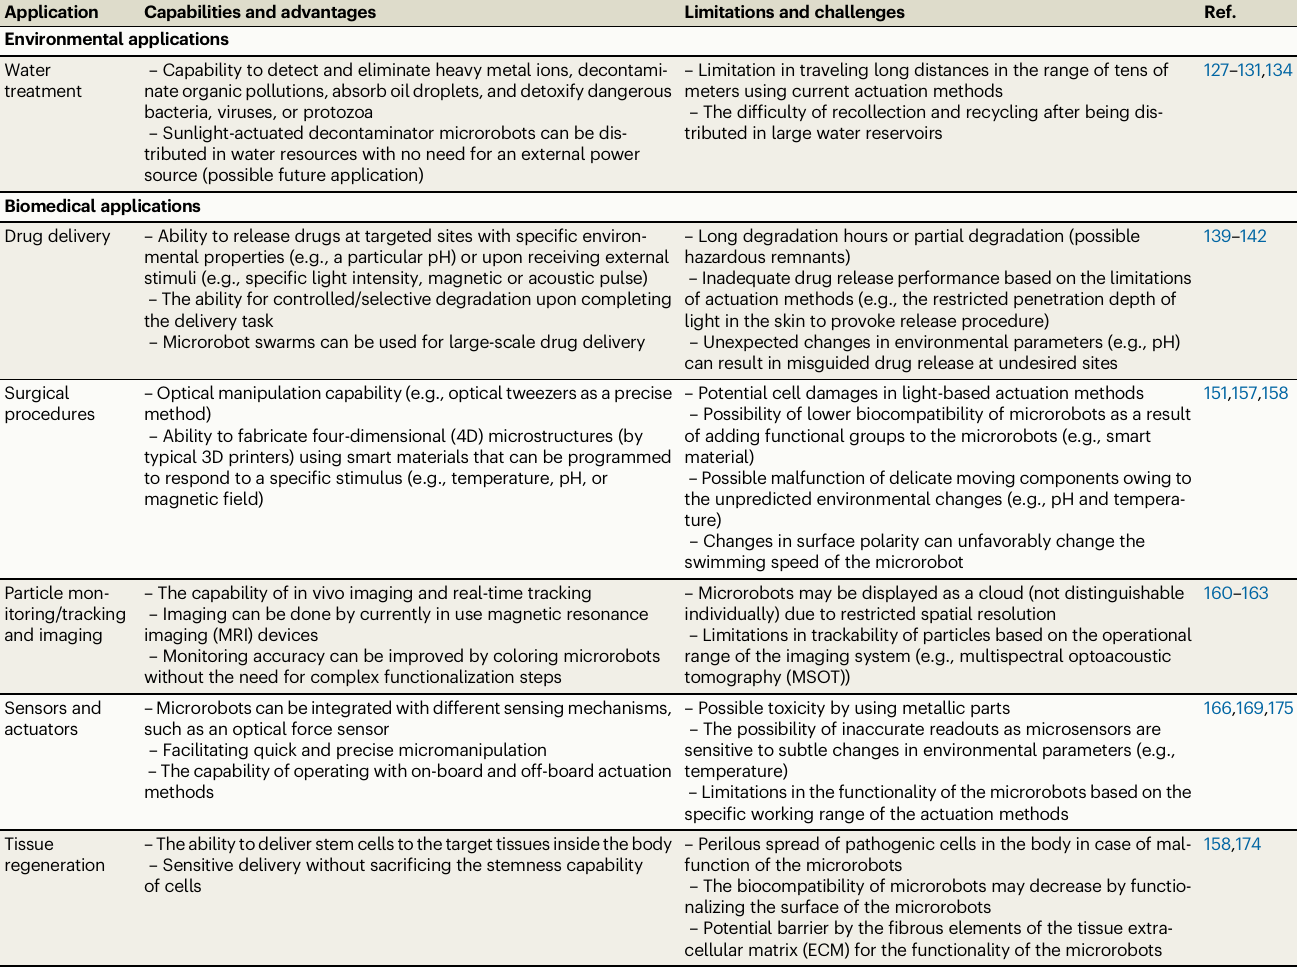
Table 3 | A summary of reported 3D-printed microrobots for different applications along with their key advantages/capabilities and